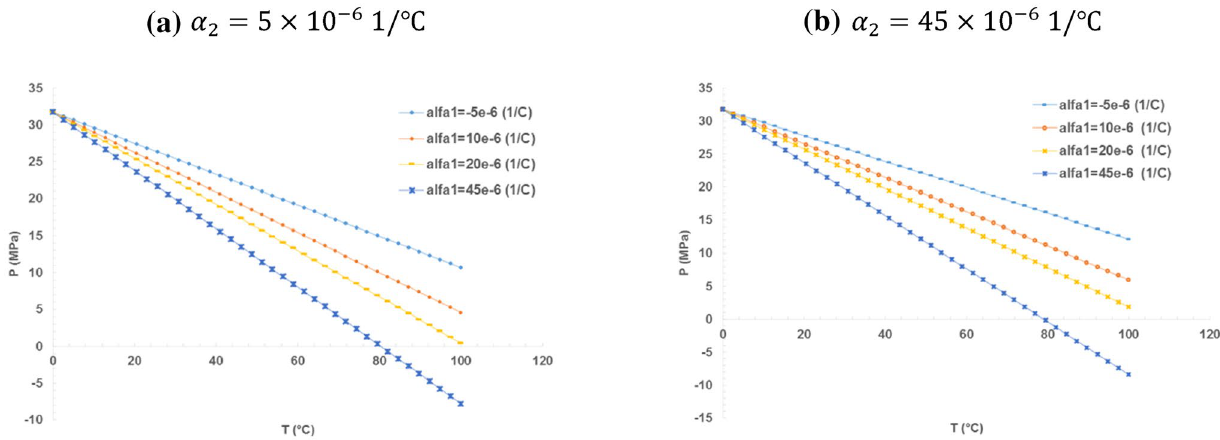
Fig. 12 Effect of different values of α 1 on the burst pressure of repaired pipe at: a low values of α 2 , b high values of α 2